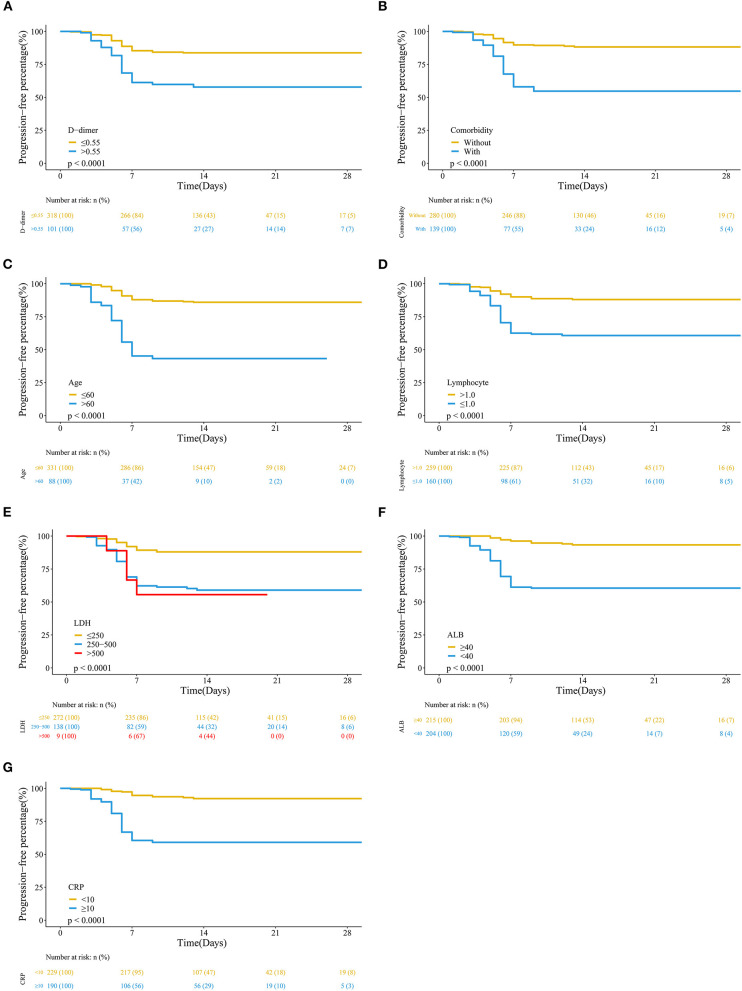
Kaplan–Meier analysis of high-risk factors for severe COVID-19. We defined the time from admission after infection and days to severe disease development or discharge. (A) D-dimer; (B) comorbidity; (C) age; (D) lymphocyte count; (E) lactate dehydrogenase (LDH); (F) albumin (ALB); (G) C-reactive protein (CRP).